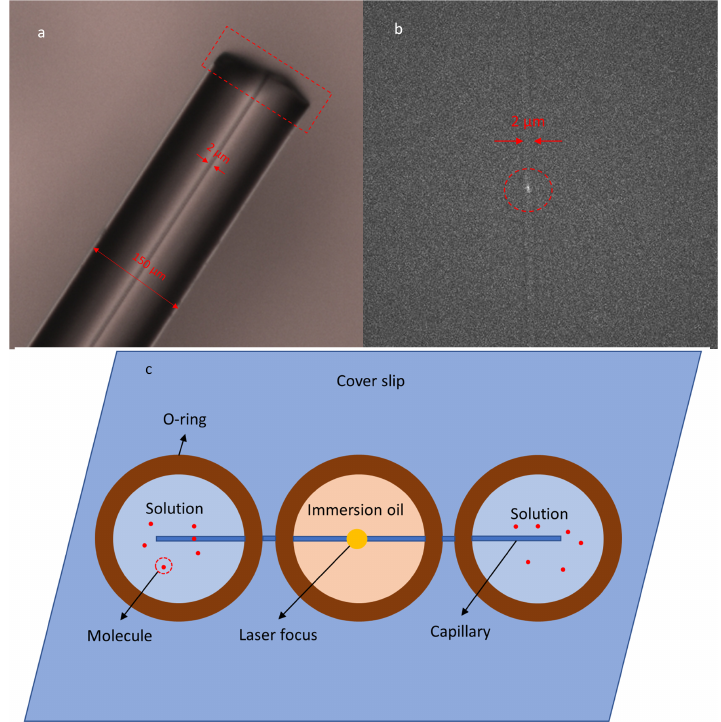
Figure 3. ( a ) The size of the capillary tubing. The red box highlights the chopped end of the capillary. ( b ) The laser focus is adjusted to the inner diameter of the capillary. The red circle highlights the laser focus inside the tube. The image is taken by the EM-CCD camera. ( c ) Schematic of the capillary microchannel device. The o-rings on the sides are reservoirs of solution, and the o-ring in the middle is the observation window for the objective. This o-ring is filled with immersion oil to reduce refraction and reflection from the outer wall of the